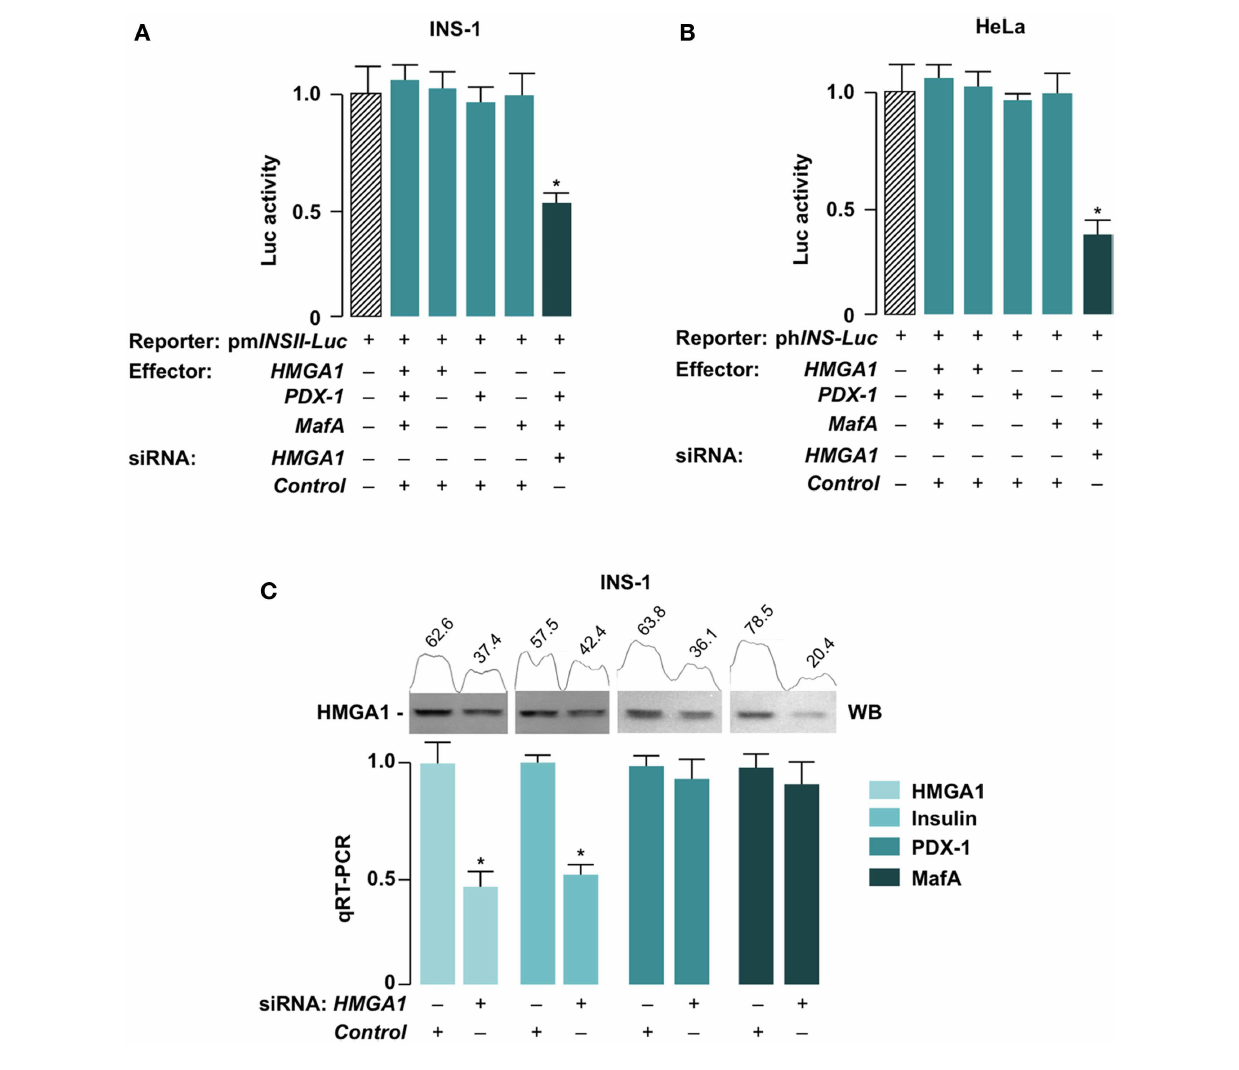
FIGURE 4 | Suppression of INS promoter and mRNA by siRNA to HMGA1 . INS-1 (A) and HeLa (B) cells were incubated without or with siRNA targeting HMGA1 (100pmol) and transfected thereafter with 1 µ g of mouse (pm INSII-Luc ) or human (ph INS-Luc ) Luc reporter plasmid, respectively, either in the absence or presence of effector vectors (0.5 µ g each) for HMGA1, PDX-1, and MafA.Values are expressed relative to the Luc activity obtained in transfections with the Luc reporter plasmid alone (slashed bar) that is assigned an arbitrary value of 1. Results are the means ± SE of triplicates from three independent transfections. * p < 0.05 versus control (slashed bar). (C) INS-1 cells were transfected with siRNA